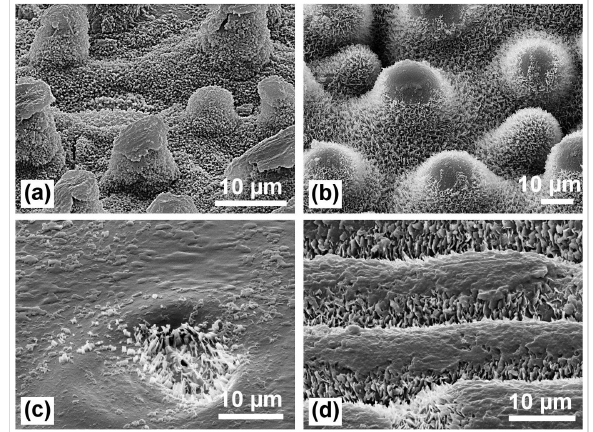
Figure 8: Test for the stability of the waxes against damaging by wiping on the same leaves: (a) Nelumbo nucifera (Lotus); (b) Euphorbia myrsinites ; (c) Brassica oleracea ; (d) Yucca filamentosa . On the papillose surfaces only the waxes on the tips of the papillae are destroyed. The waxes between the papillae are protected and remain intact. On the non-papillose surfaces, most of the waxes are destroyed, adhesion of water drops (pinning) is strongly increased, and the superhydrophobicity is lost.